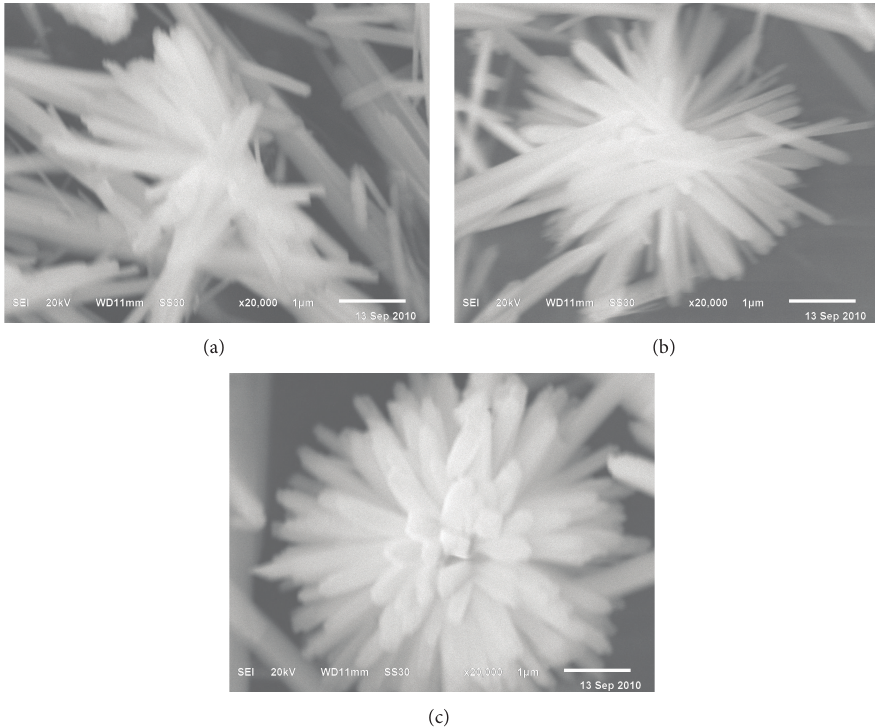
Figure 4: SEM images of the SmVO 4 nanocrystals synthesized under pH = 9.7, with different reaction temperatures: (a) EDTA, 140 ∘ C; (b) EDTA, 160 ∘ C; (c) EDTA, 180 ∘ C.